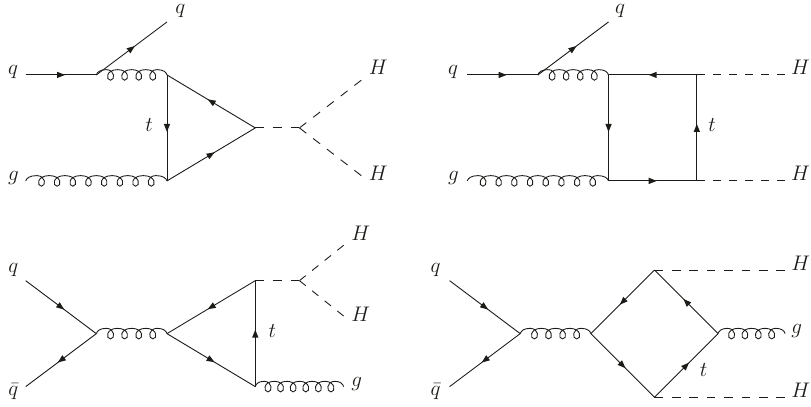
Figure 9 . Typical one-loop triangle and box diagrams for the partonic channels qg row) and q (cid:22) q HHg (lower row), contributing to the real corrections of Higgs-pair production via ! gluon fusion at NLO in